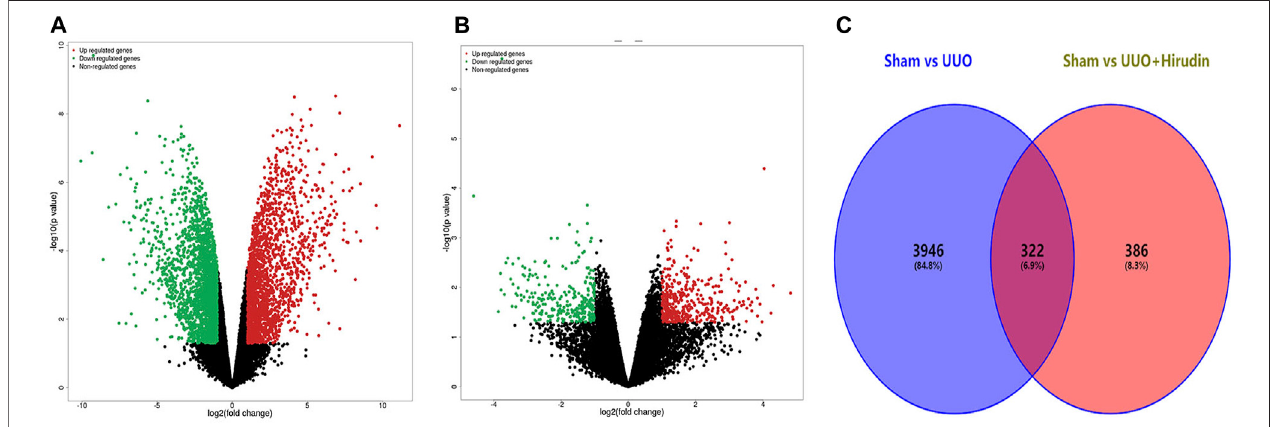
FIGURE 3 | Transcriptomic assay and bioinformatics analysis. (A) Compared Sham group with UUO group, fi ltering of DEGs was presented by volcano. (B) ComparedUUO hirudin-treatedgroup withUUO group, fi lteringofDEGswaspresented byvolcano. (C) Venndiagramofoverlappinggenesderived fromtranscriptome analysis in a pairwise comparison. Red color represents upregulated genes, while green color shows downregulated genes.